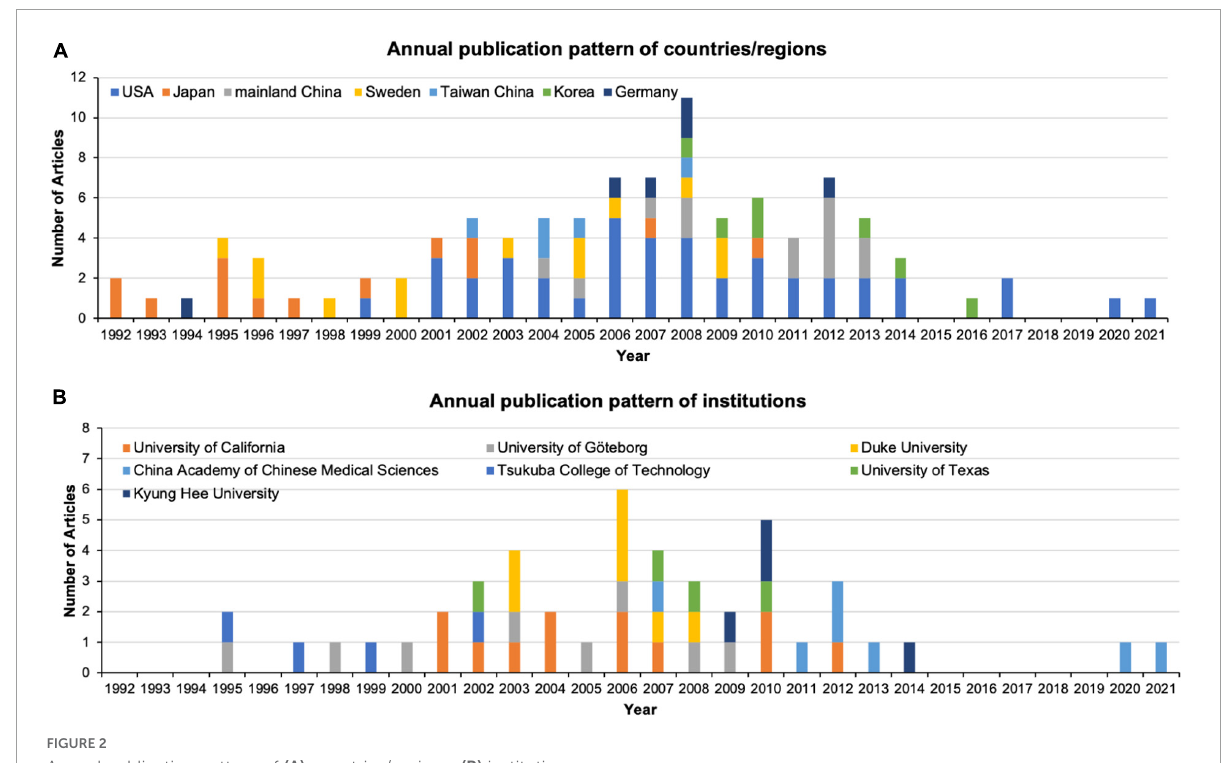
FIGURE2 Annual publication pattern of (A) countries/regions; (B) institutions.